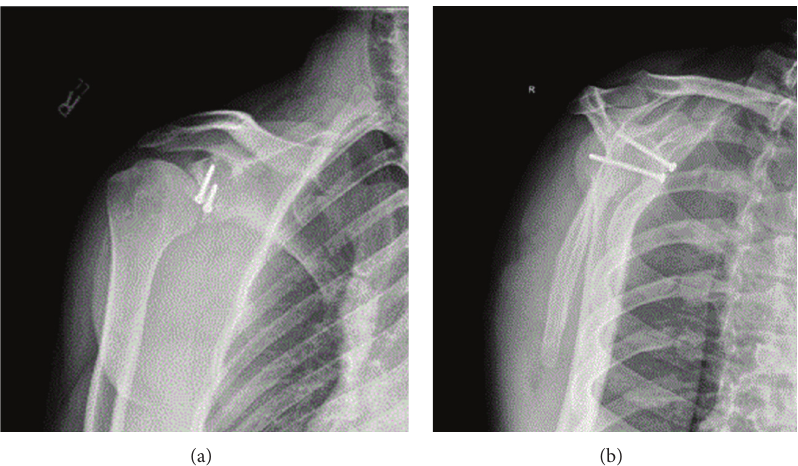
Figure 7: Two views of the right shoulder following an open Latarjet stabilization procedure for recurrent right shoulder instability.